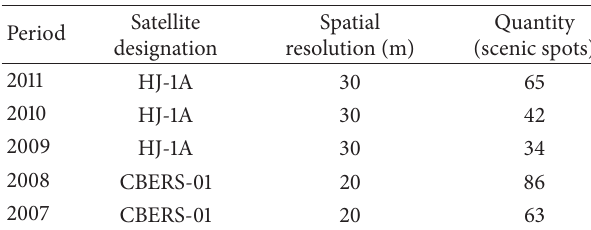
Table 1: Image details in